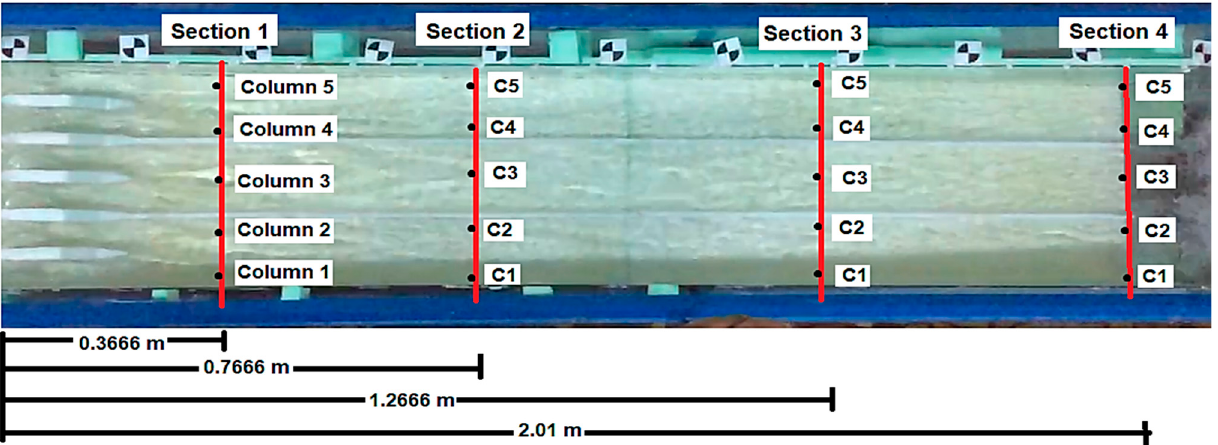
Figure 5. Velocity measurement points and location (distances from starting point) of the spillway model in the hydraulic water channel (top view).